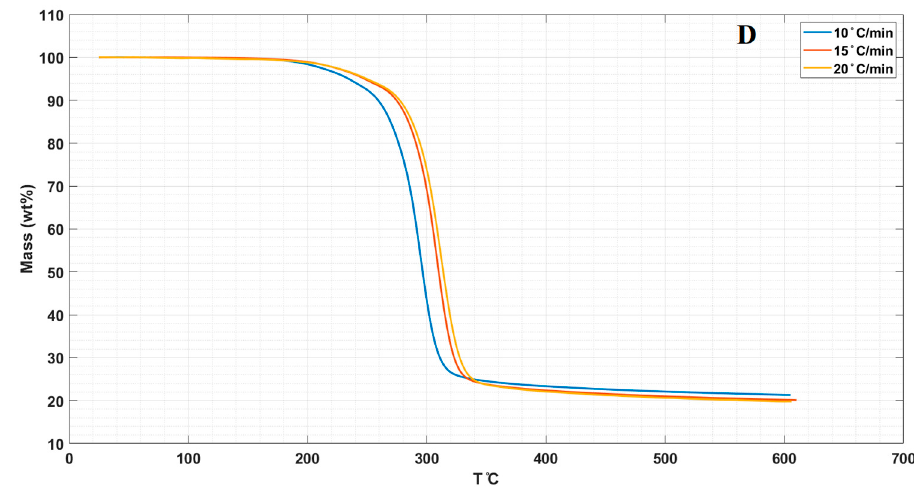
Figure 5. TGA curves in 3 different heating rates for ( A ) LPS, ( B ) LPS/CNPs 1%, ( C ) LPS/CNPs 3%, and ( D ) LPS/CNPs 5%.